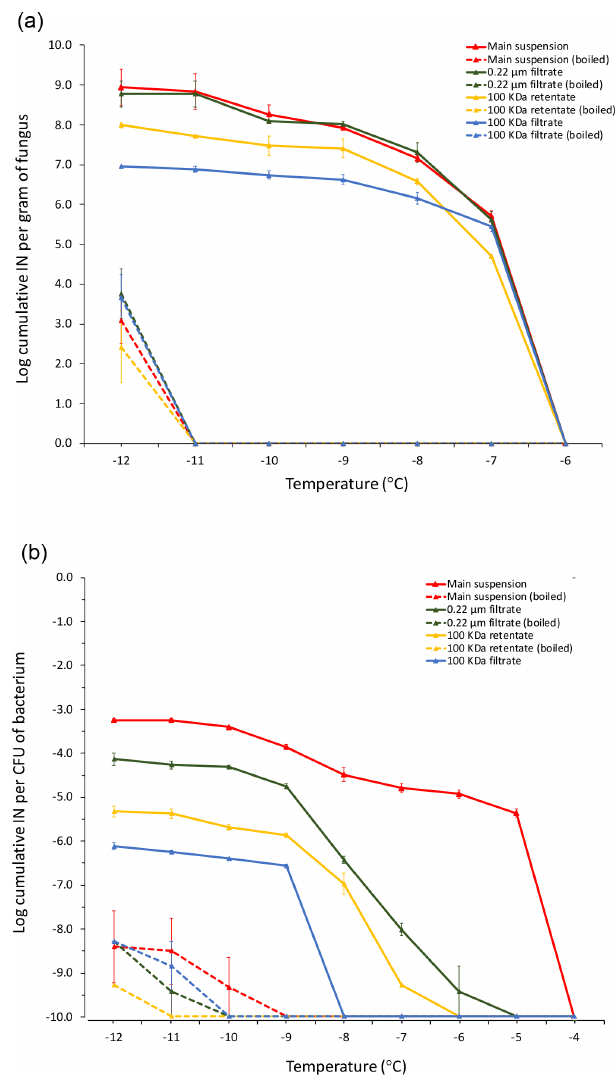
Figure 4. Cumulative ice nucleation spectra of M. alpina strain LL118 (a) isolated from leaf litter sample 70-S-14 and of Pa. ana- natis BAV 3057 (b) isolated from rain, but over 99% identical in its 16S rRNA sequence to the two Pa. ananatis isolates from sample 70-S-14. The analyzed fractions derived from differential filtration and boiling are the same as shown in Fig. 1; besides that, instead of leaf litter, suspensions of M. alpina mycelium and of a Pa. ana- natis bacterial suspension were used as the starting material. IN: ice nuclei; CFU: colony-forming